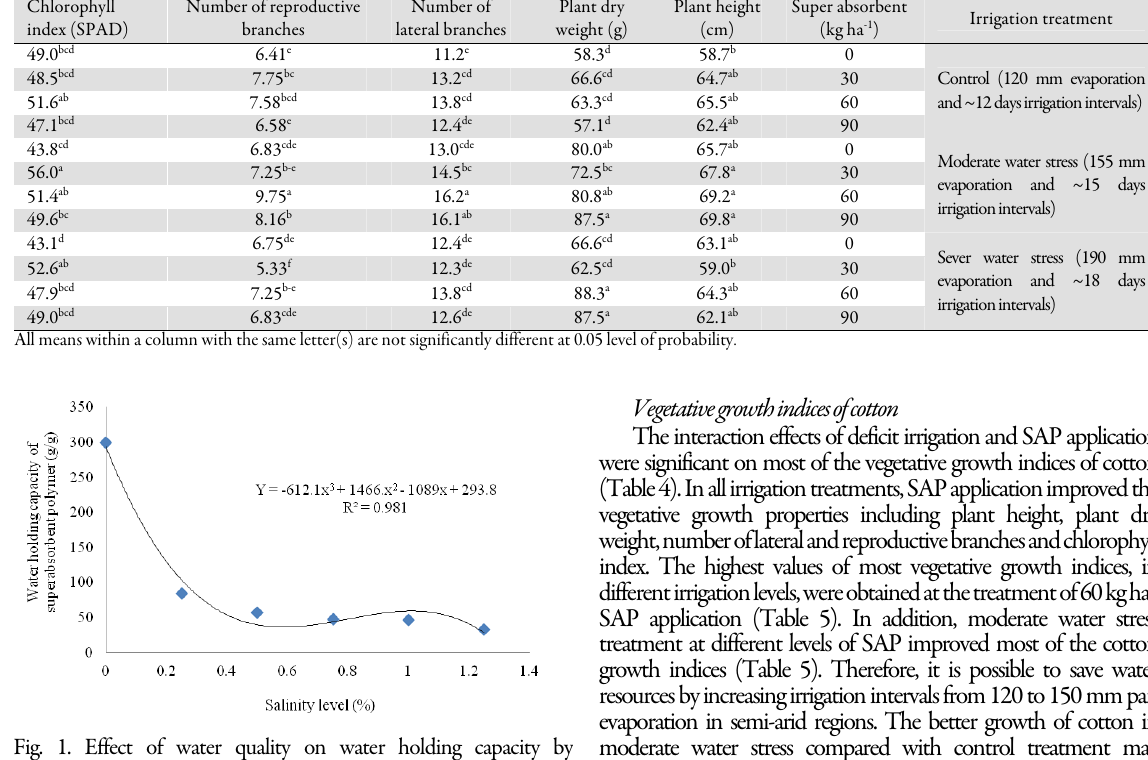
Table 5. Means comparison for interaction effects of irrigation management and super absorbent polymer (potassium polyacrylate and polyacrylamide copolymers) application on vegetative growth indices of cotton Chlorophyll index